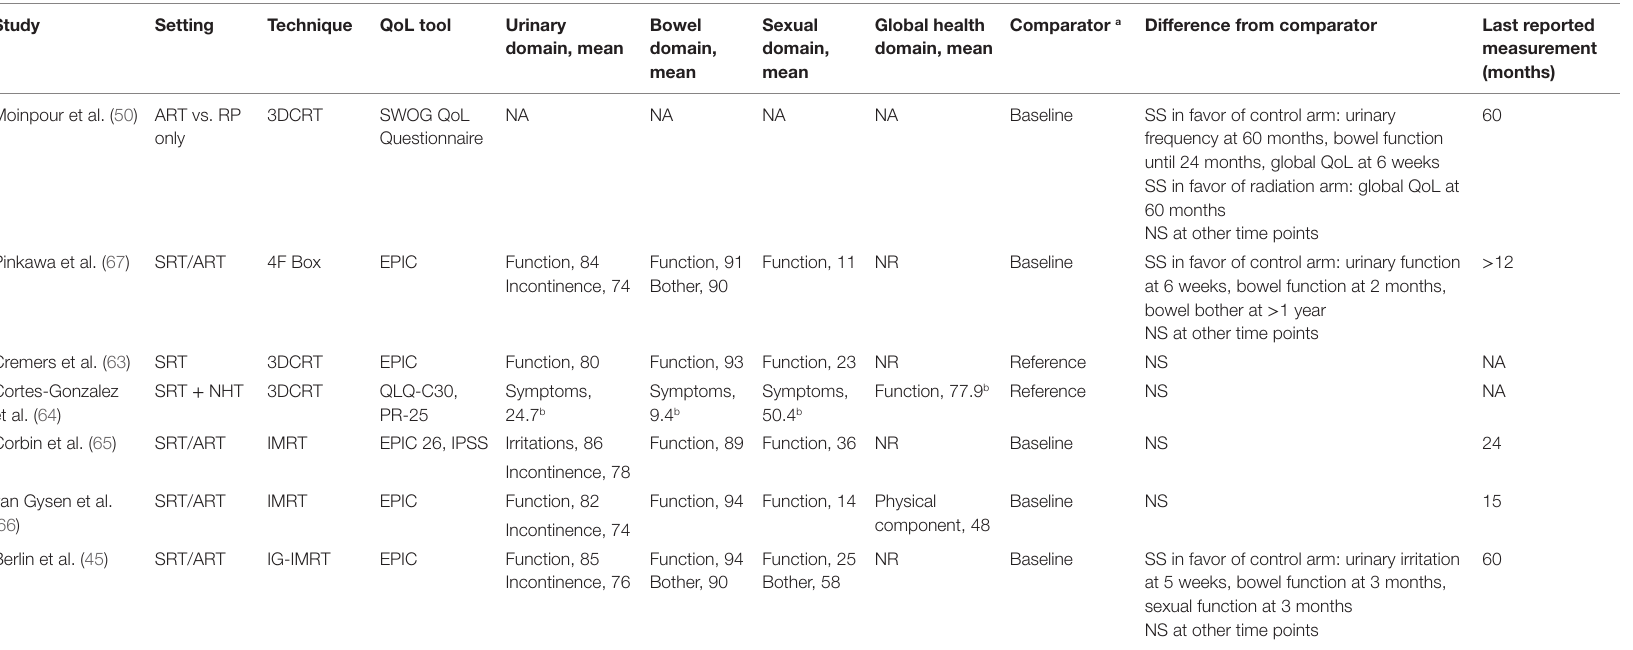
TABLe 2 | Summary of studies on patient-reported QoL indicators.